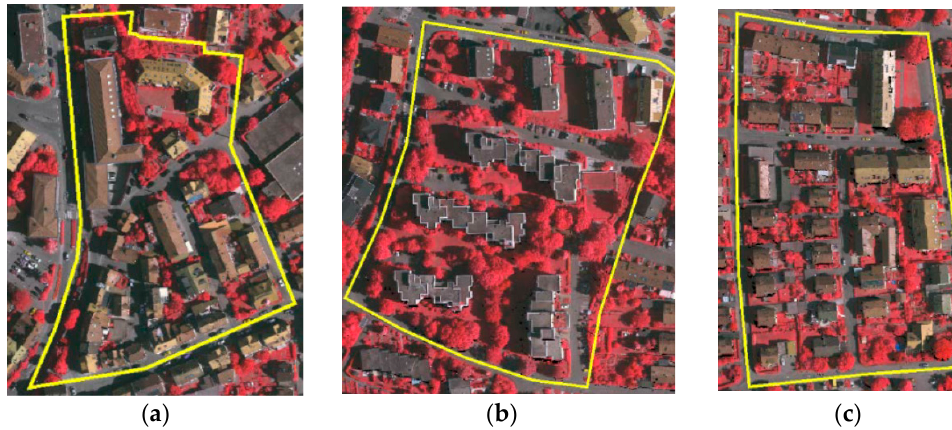
Figure 4. The tested three datasets provided by the ISPRS. ( a ) Area1; ( b ) Area2; ( c )